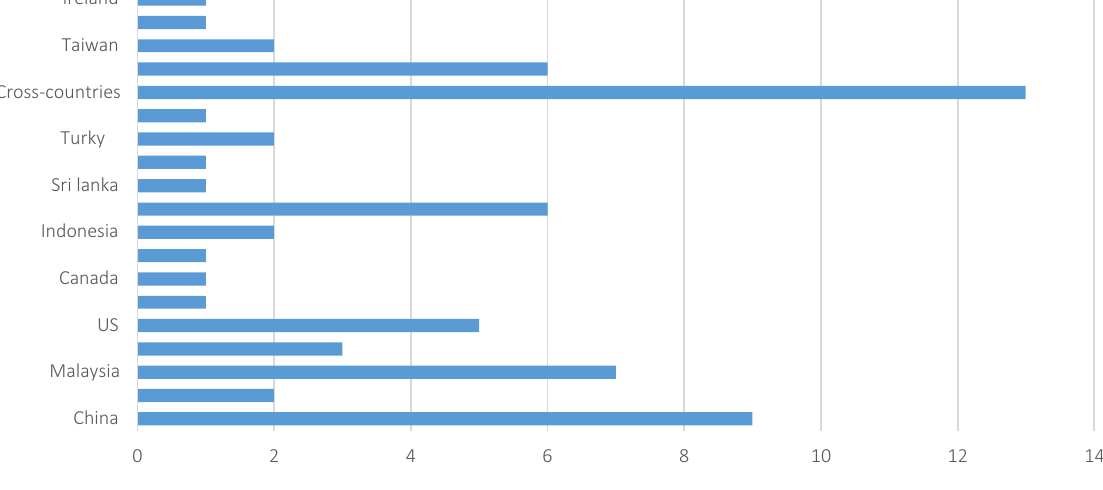
Figure 4. Country